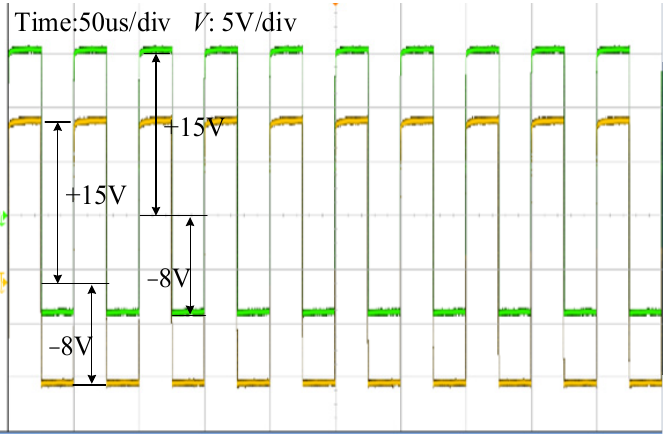
Figure 14. The drive waveform of IGBTs.